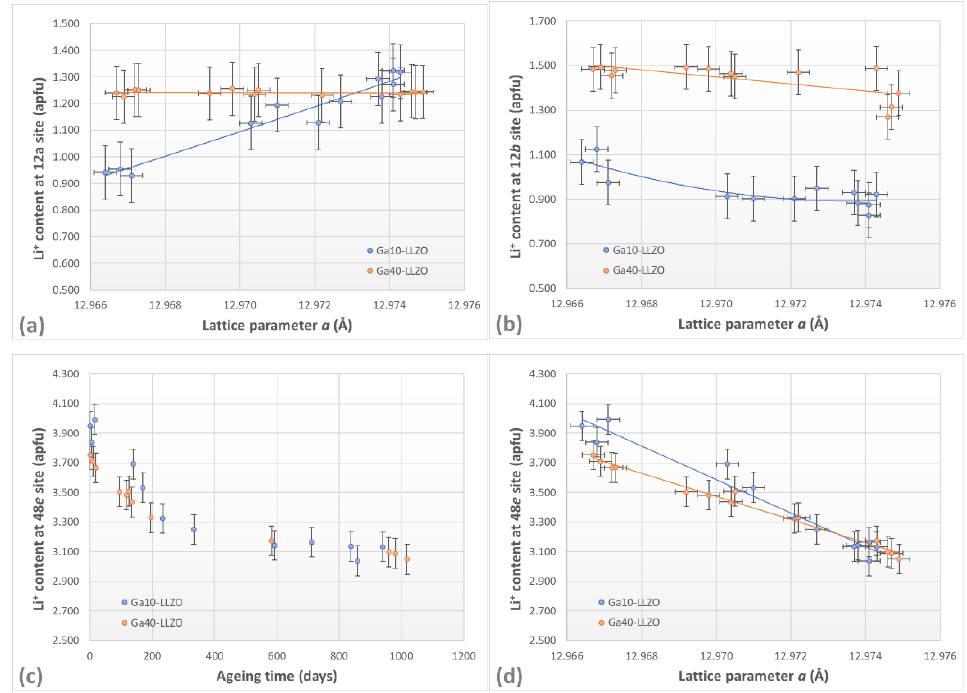
Figure 10. Variation of site occupation numbers in Ga-dopped LLZO as a function of lattice parameter ( a , b , d ) and storage time ( c ).